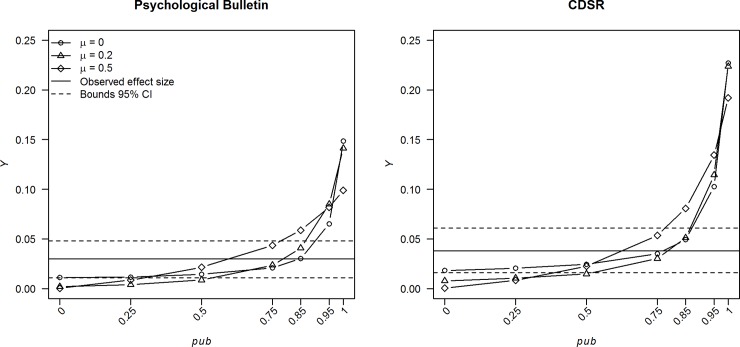
Overestimation (Y) of the random-effects model when compared with the 10% most precise observed effect sizes for simulated data based on characteristics of subsets from meta-analyses published in Psychological Bulletin (left panel) and Cochrane Database of Systematic Reviews (CDSR; right panel).pub refers to the extent of publication bias and open bullets, triangles, and diamonds indicate no, small, and medium average true effect size. The solid line indicates the mean of the Y-variable observed in the homogeneous subsets and the dashed lines are the upper and lower bound of a 95% confidence interval (CI) around the mean of the Y-variable.